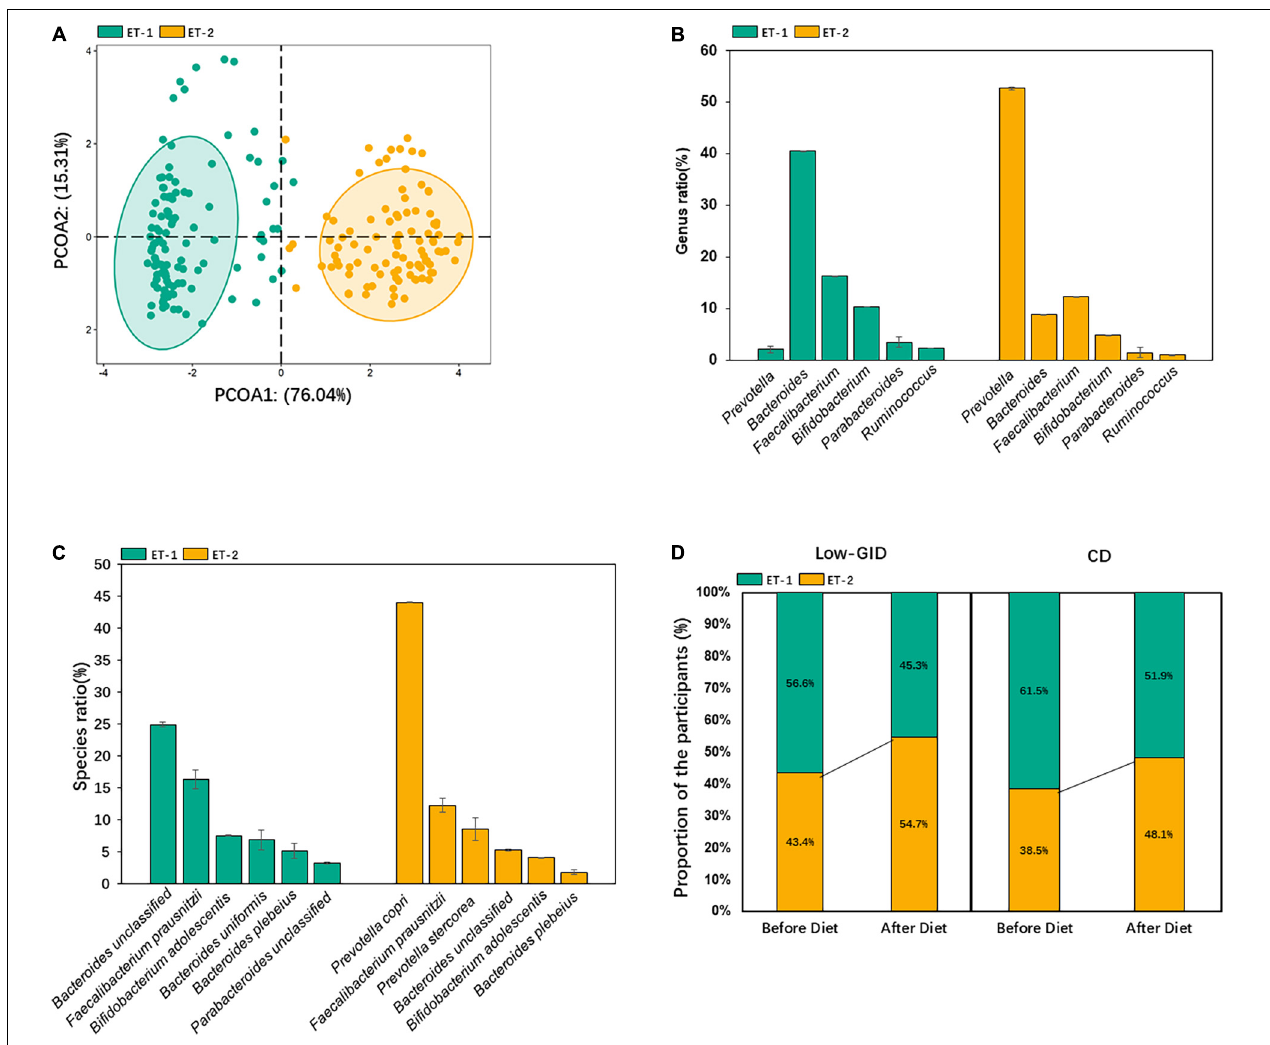
FIGURE 1 | Classification of enterotypes in the participants. (A) Classification map based on the principal coordinates of enterotype classification at the genus level. (B) The relative abundance of dominant bacteria at the genus level of each enterotype. (C) The relative abundance of dominant bacteria at the species level of each enterotype. (D) Changes of enterotype after the intervention of host